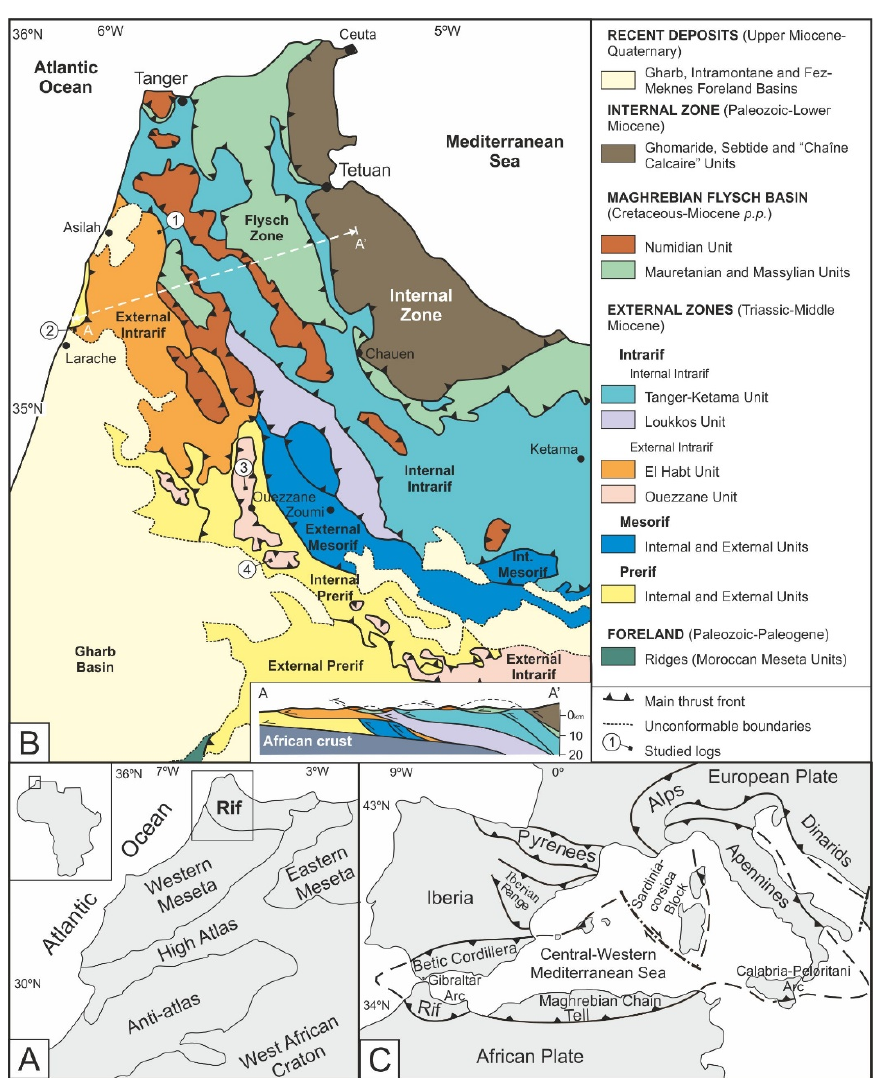
Figure 1. ( A ) Simplified map of the north-western African area; ( B ) Simplified tectonic sketch map of the central-western peri-Mediterranean chains (after [11], modified); ( C ) Geological sketch map of the central-western Rif Chain (after [21], modified).